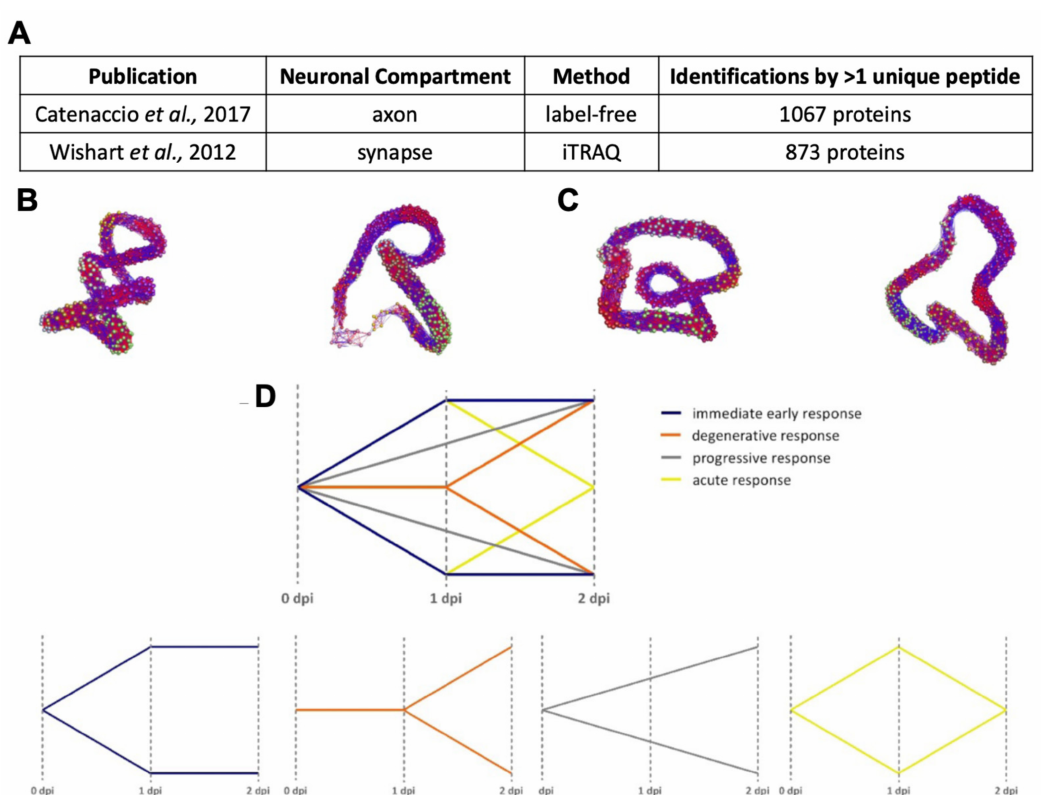
Figure A1. ( A ) Summary of source datasets derived from studies by [124,125] profiling, respectively, murine synaptic (following cortical lesion injury) and axonal isolates (following sciatic nerve crush injury). Table summarises labelling method employed, number of analysis-ready proteins as identi- fied by the presence of 2 or more unique peptides, and main findings following downstream analysis as described by the authors. ( B , C ) BioLayout3D representation of ( B ) WT synaptic and ( C ) WT axonal protein expression status through 1 dpi and 2 dpi relative to day of injury (0 dpi). Each node represents an individual protein, and lines represent the magnitude of expression correlation between proteins across the three time points profiled in each study (0, 1, and 2 dpi). Input was clustered based on similarity in expression profile over time, and individual nodes are colourised to represent identity within output clusters. Correlation threshold is defined by Pearson r = 0.97. ( D ) Representative ex- pression profile graphs illustrating potential responses of protein subsets following injury, indicating putative immediate early, degenerative, progressive, and acute response